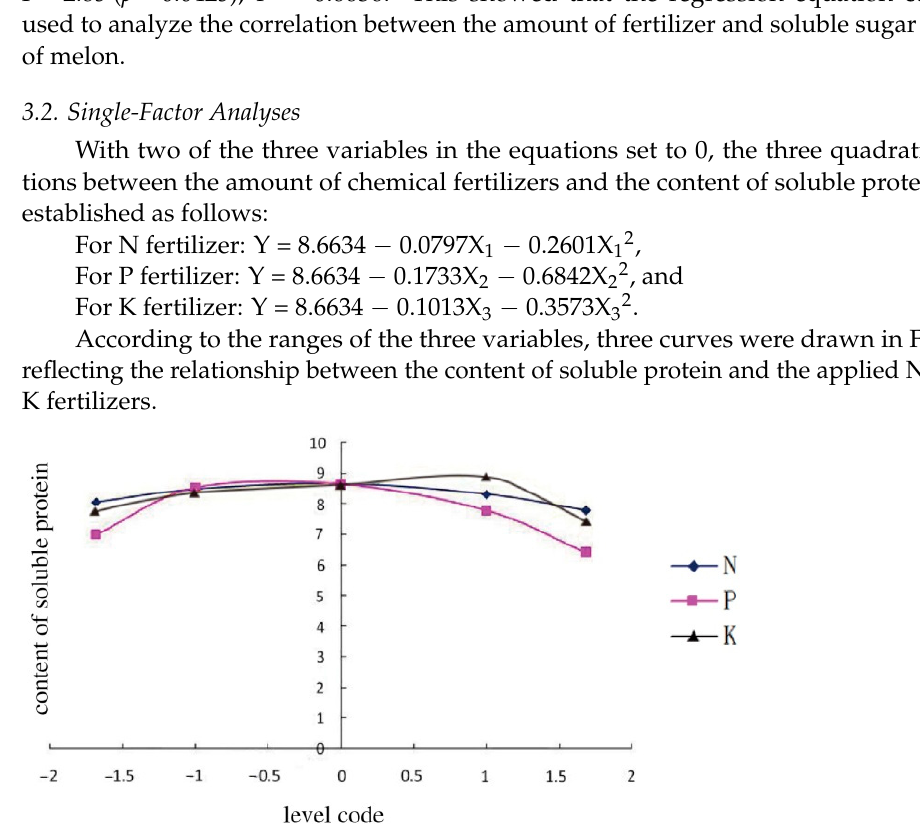
Figure 1. The effect of the application amount of N, P, and K on the soluble protein content in melon. The content of soluble proteins increased with the level of chemical N fertilizer in a range from − 1.682 to 0.5865, attaining the maximum at a fertilization level of